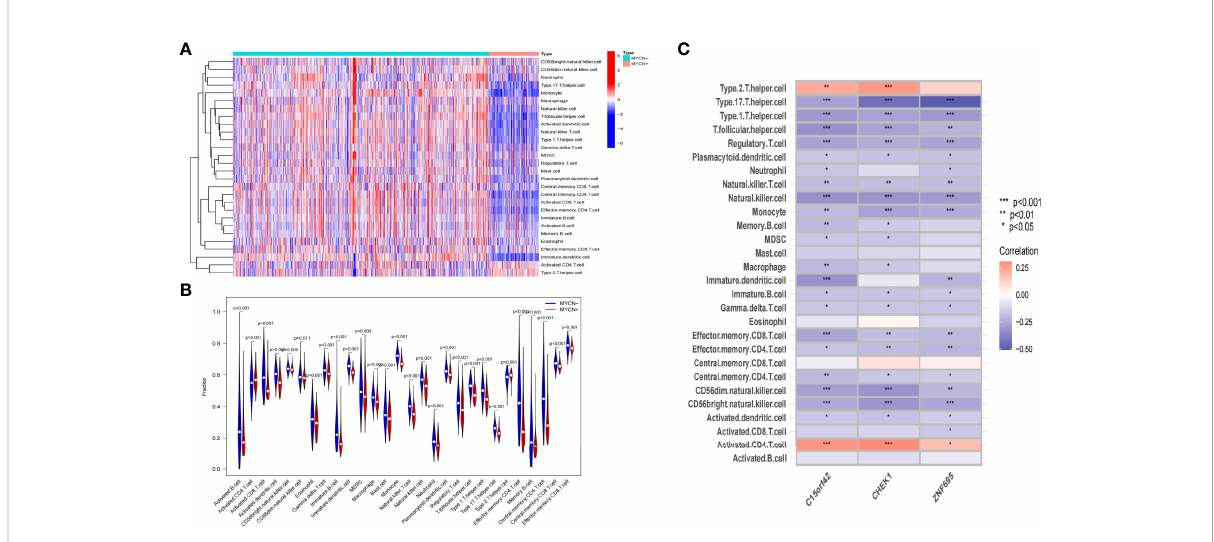
FIGURE 9 Correlation between immune-related cells and MYCN -related hub genes in NB (A) Heatmap shows the compositions of in fi ltrated immune cells between MYCN positive and MYCN negative group with a total of 1136 NB cases. (B) The violin plot shows the abundance of 28 immune- related cells in 1136 cases, comparisons between immune cells in MYCN positive and MYCN negative NB. (C) Heatmap shows the correlations between 28 immune-related cells and three hub genes in 1136